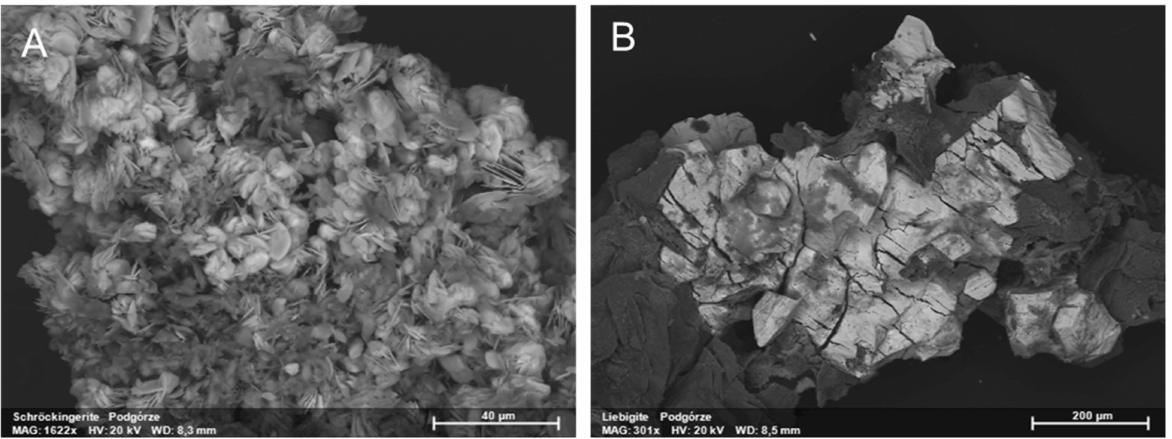
Figure 10. Clusters of uranyl carbonates from Podg ó rze mine: ( A ) schröckingerite; ( B )